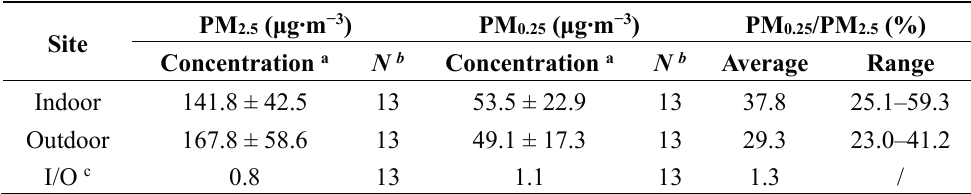
a Values represent average ± standard deviation; b PM concentration to PM mass